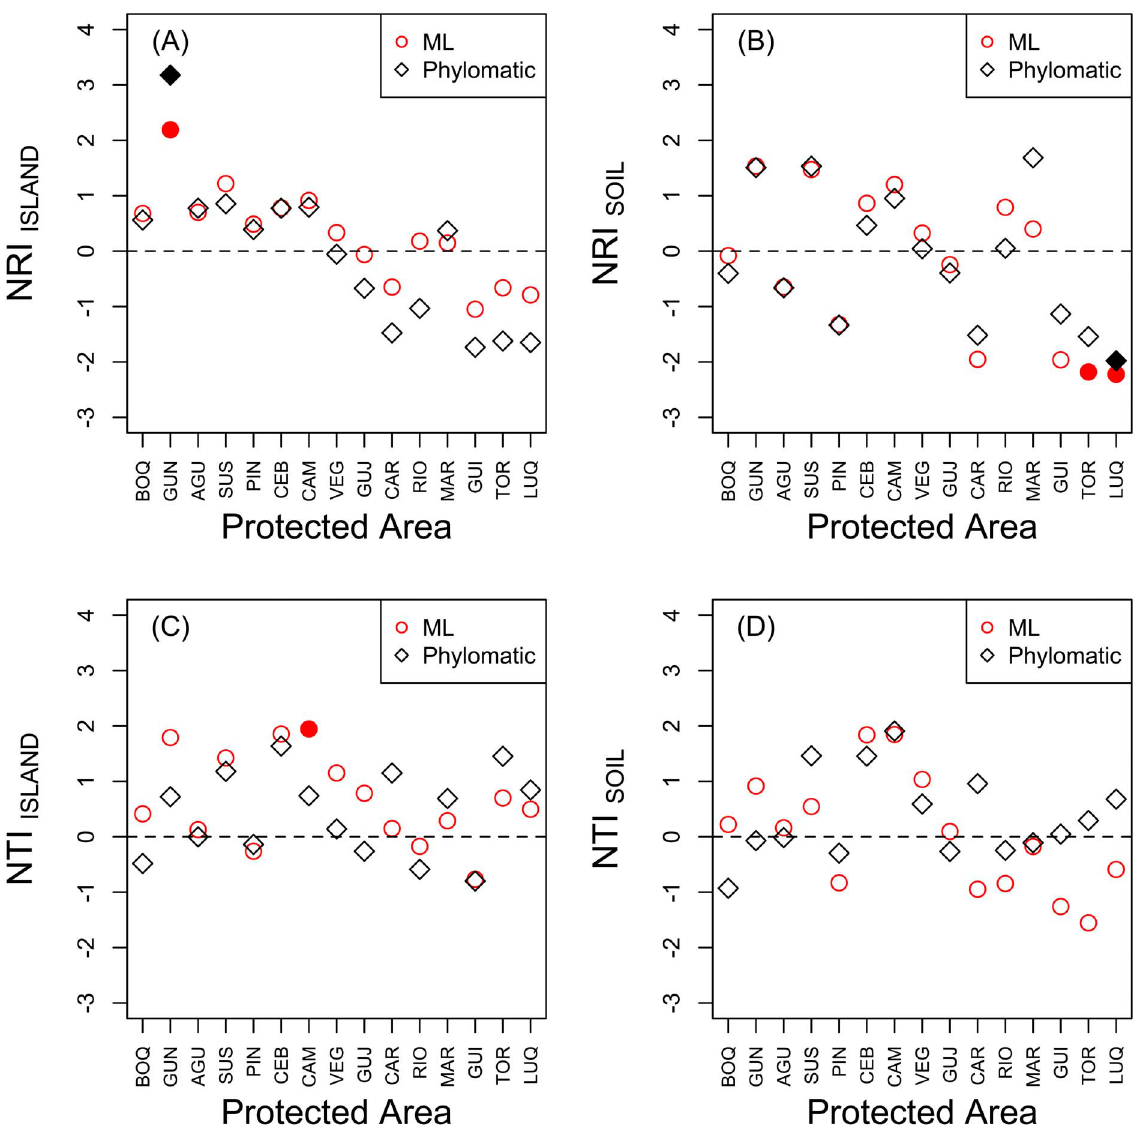
Figure 3. The net relatedness index (NRI) (A, B) and nearest taxon index (NTI; C, D) based on species occurrence records from Little & Wadworth [63] and Little etal . [64] versus reserve area [90] for 15 state forests in Puerto Rico. Leftmost panels are based on a null phylogen-model using the full island species pool; right panels (B, D) are based on species pools restricted to primary soil types. Forests are sorted from codes.to right in order of their mean annual precipitation. Positive values indicate phylogenetic clustering and negative values indicate etic evenness. Filled symbols indicate values that are significantly different from a null model. Refer to Table 1 for forest